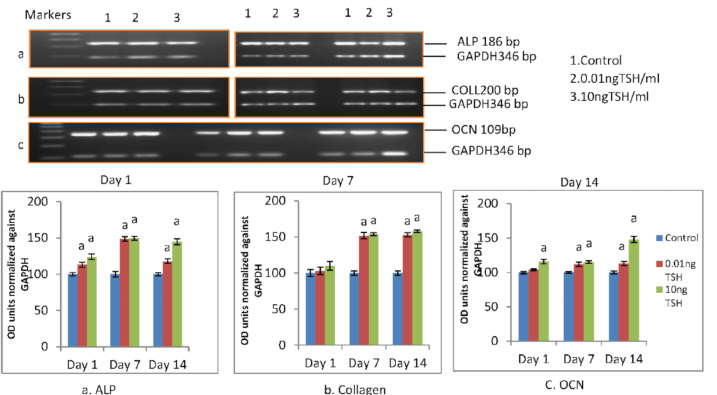
Figure 4. Effect of TSH on Osteocalcin, collagen and ALP mRNA expression in SaOS-2 cells. Each bar diagram shows mean ± SEM of three experiments; ‘a’ represents compared with control at p < 0.05.